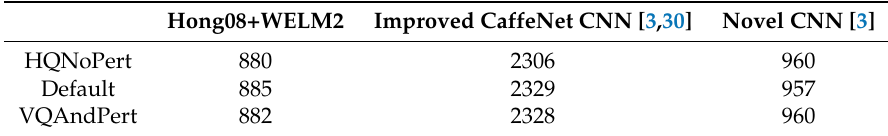
Table 6. Comparison in terms of the model learning time expressed in